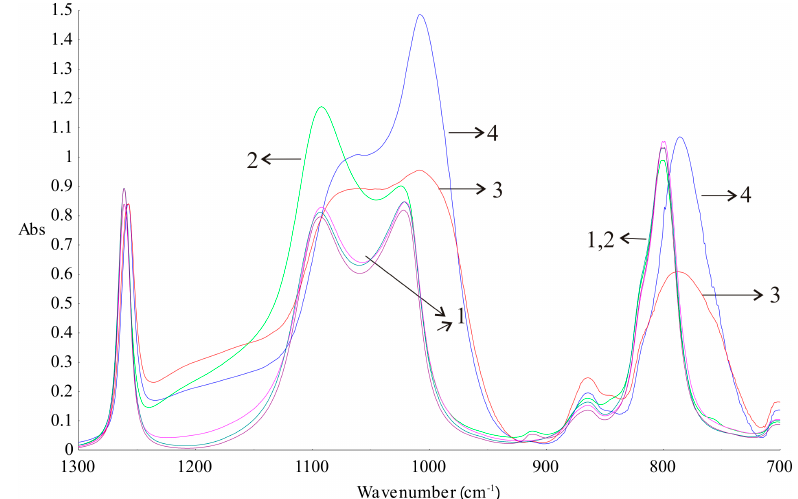
Figure 9. Attenuated total reflectance–Fourier-transformed infrared (ATR – FTIR) spectrum of silicone components ( 1 —Gumosil Part B, DC A, DC B; 2 —Gumosil Part A) and silicone elastomers ( 3 —Gumosil after curing reaction; 4 —DC after curing reaction).